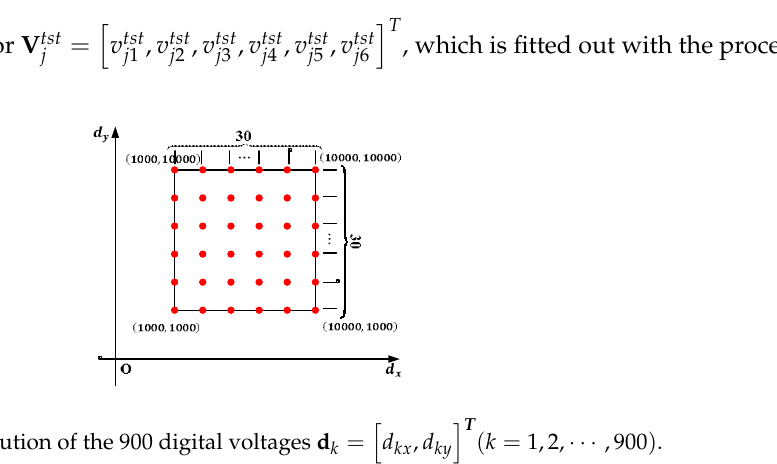
(cid:2176) ((cid:1863) = 1,2, ⋯,900) (cid:104) (cid:105) T = ( k = 1,2, · · · ,900 ) d kx , d ky k